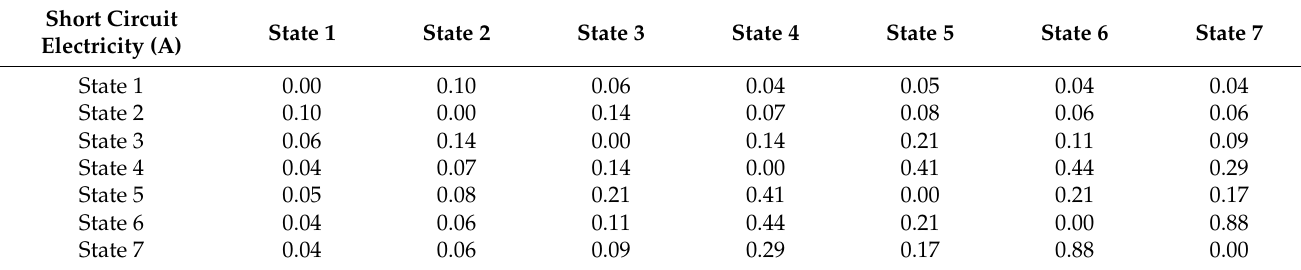
Table 5. Values determining the visibility of the distance between the quality of states of the PV criterion, i.e., short-circuit